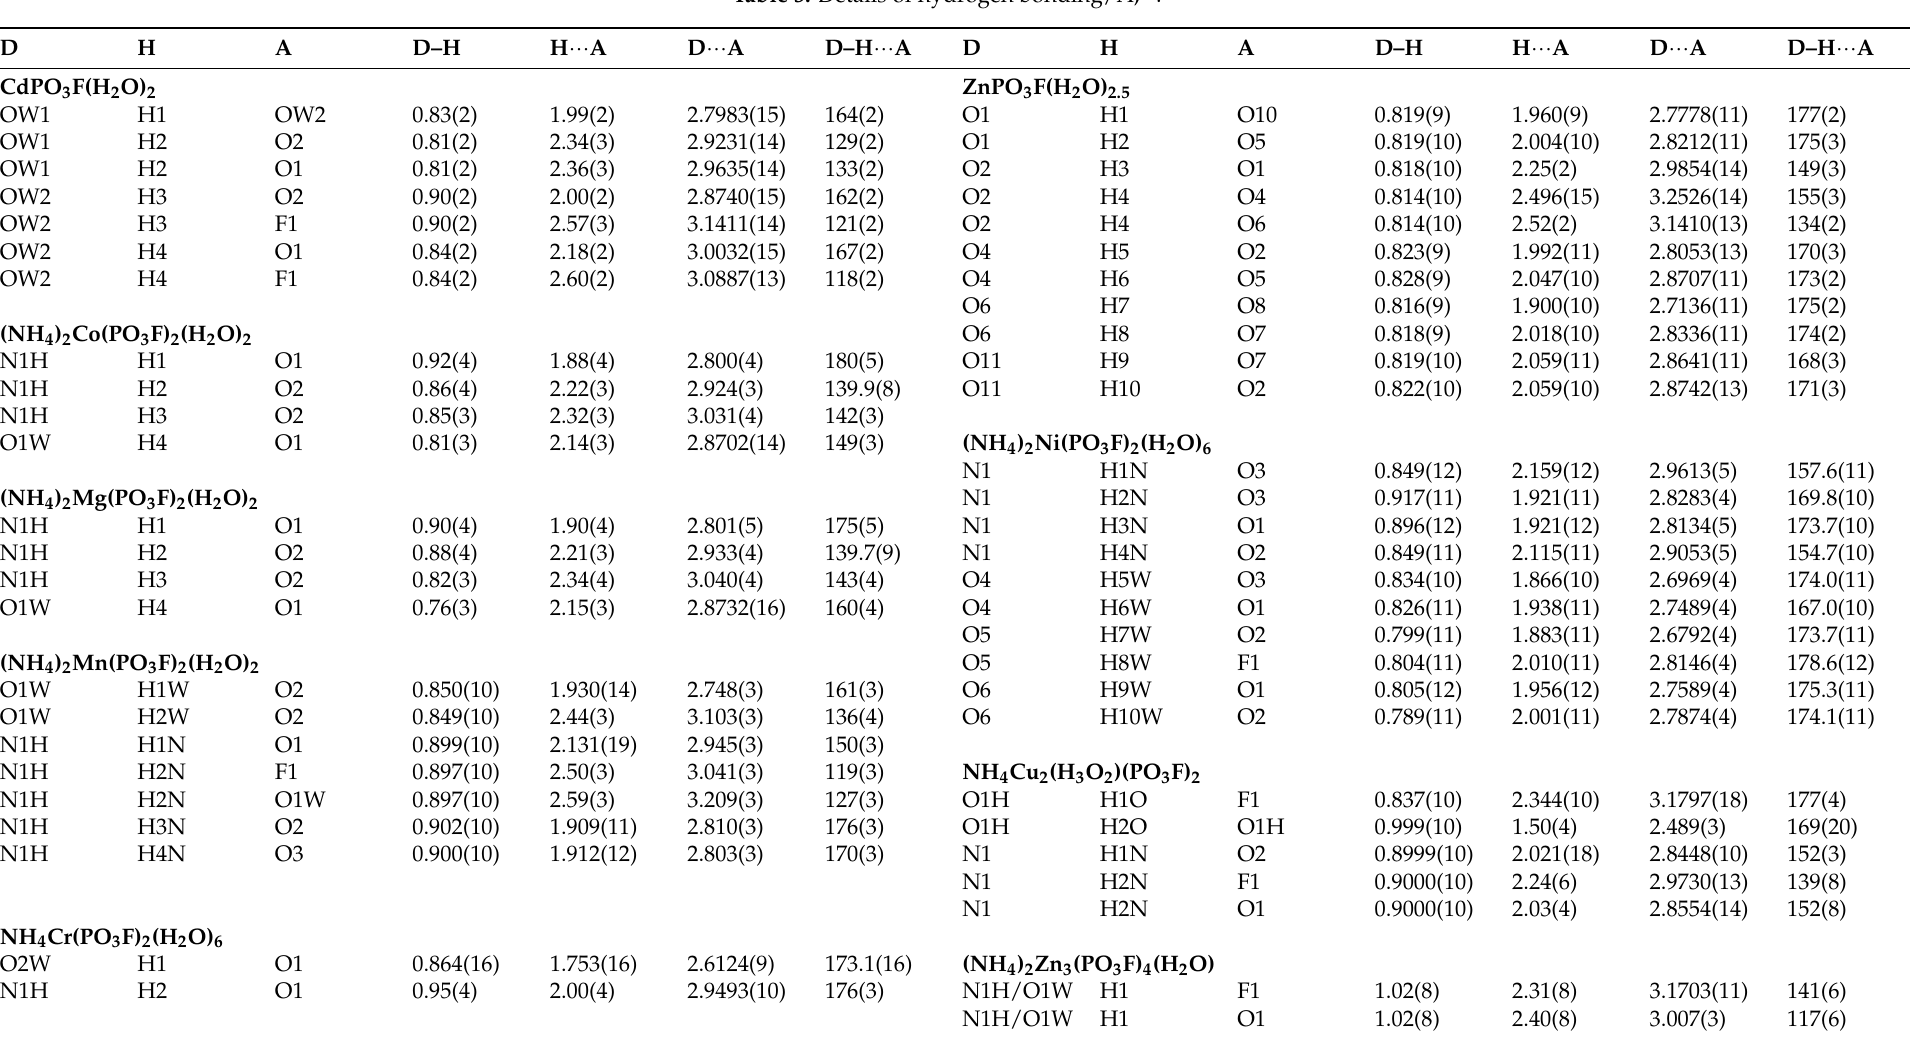
Table 3. Details of hydrogen bonding/Å, ◦